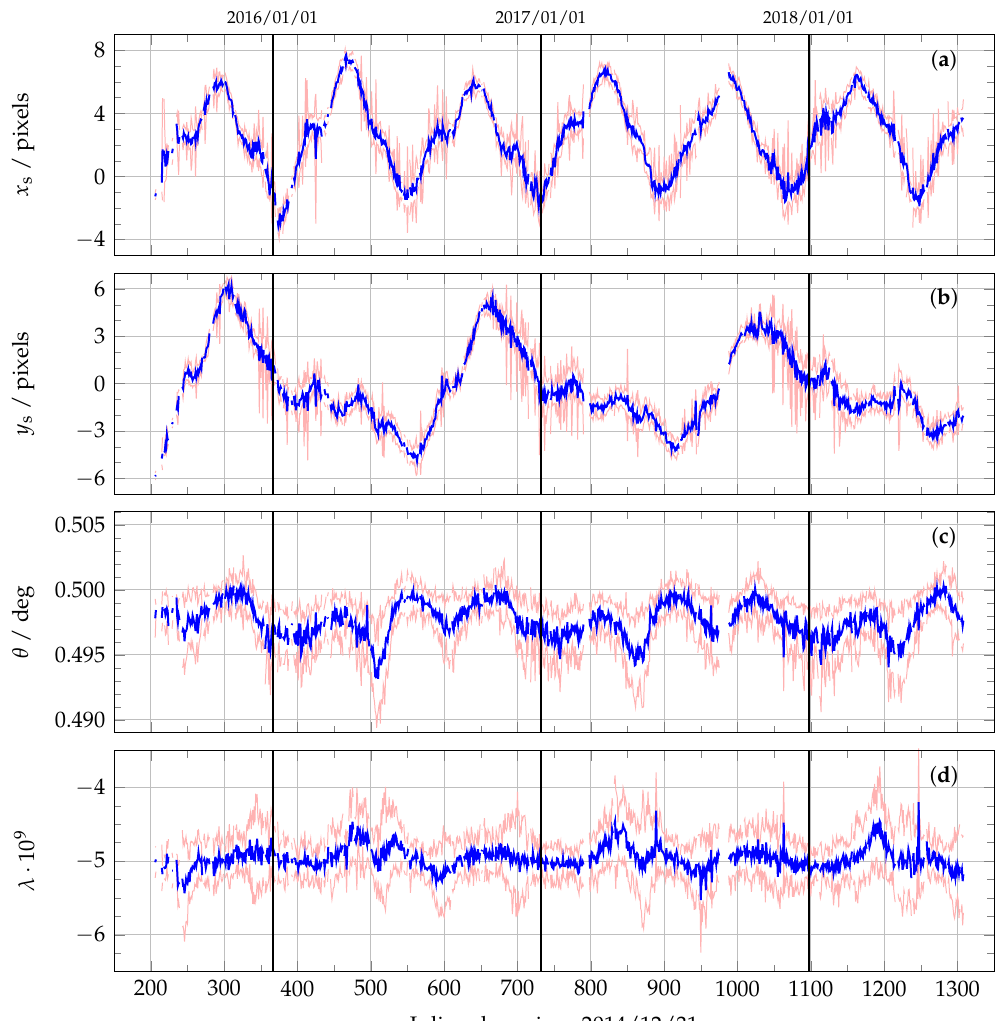
Figure 8. Time series plot for every transformation parameter: ( a ) the horizontal shift x s ; ( b ) the vertical shift y s ; ( c ) the rotation angle θ ; and ( d ) the radial distortion parameter λ . The blue lines represent the evolution of the daily mean value for every parameter, while the light red curves represent the daily dispersion of each parameter given as the daily mean value plus/minus the daily standard